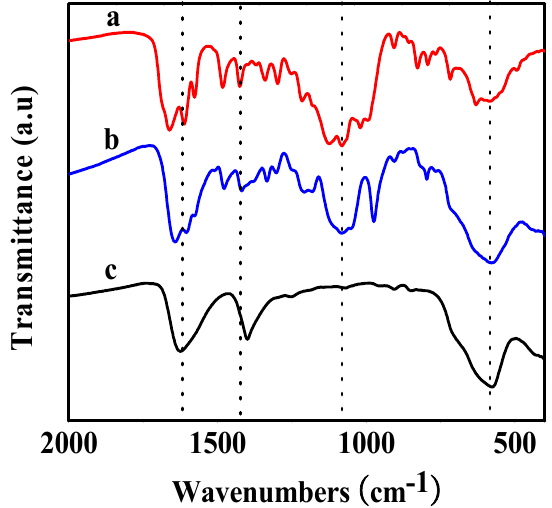
Figure 2. The FTIR spectra of CA-Fe 3 O 4 @Zn/AMP (curve a ), CA-Fe 3 O 4 & AMP (curve b ) and CA-Fe 3 O 4 NPs (curve c ).